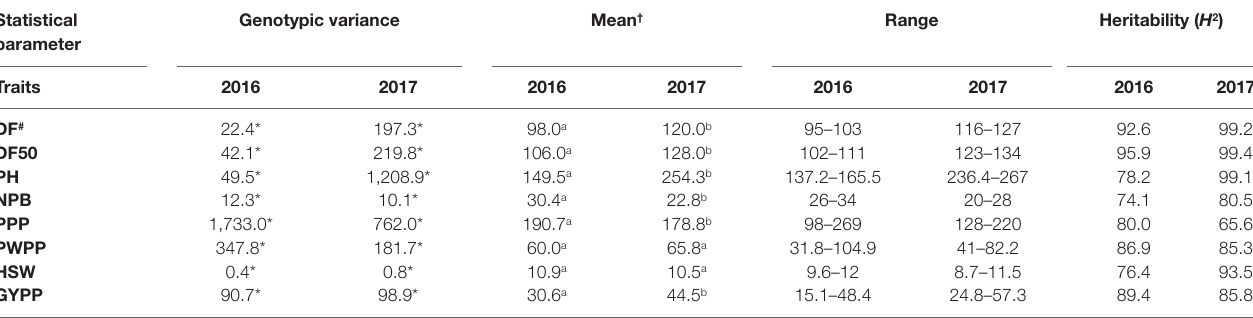
TABLE 4 | Variance components due to genotypes ( ) σ g2 , mean, range, and heritability ( H 2 ) of agronomic traits in Trial 03 at ICRISAT Patancheru during the 2016 and 2017 rainy seasons. Statistical parameter